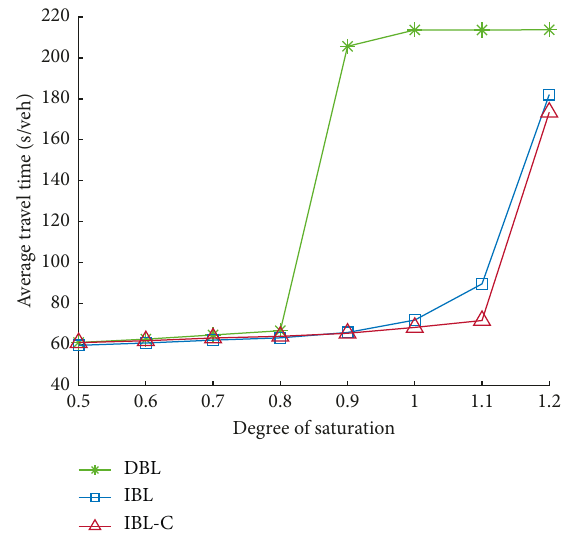
Figure 14: Average traffic time of regular vehicles with near-side stop when the interval of buses’ is random.